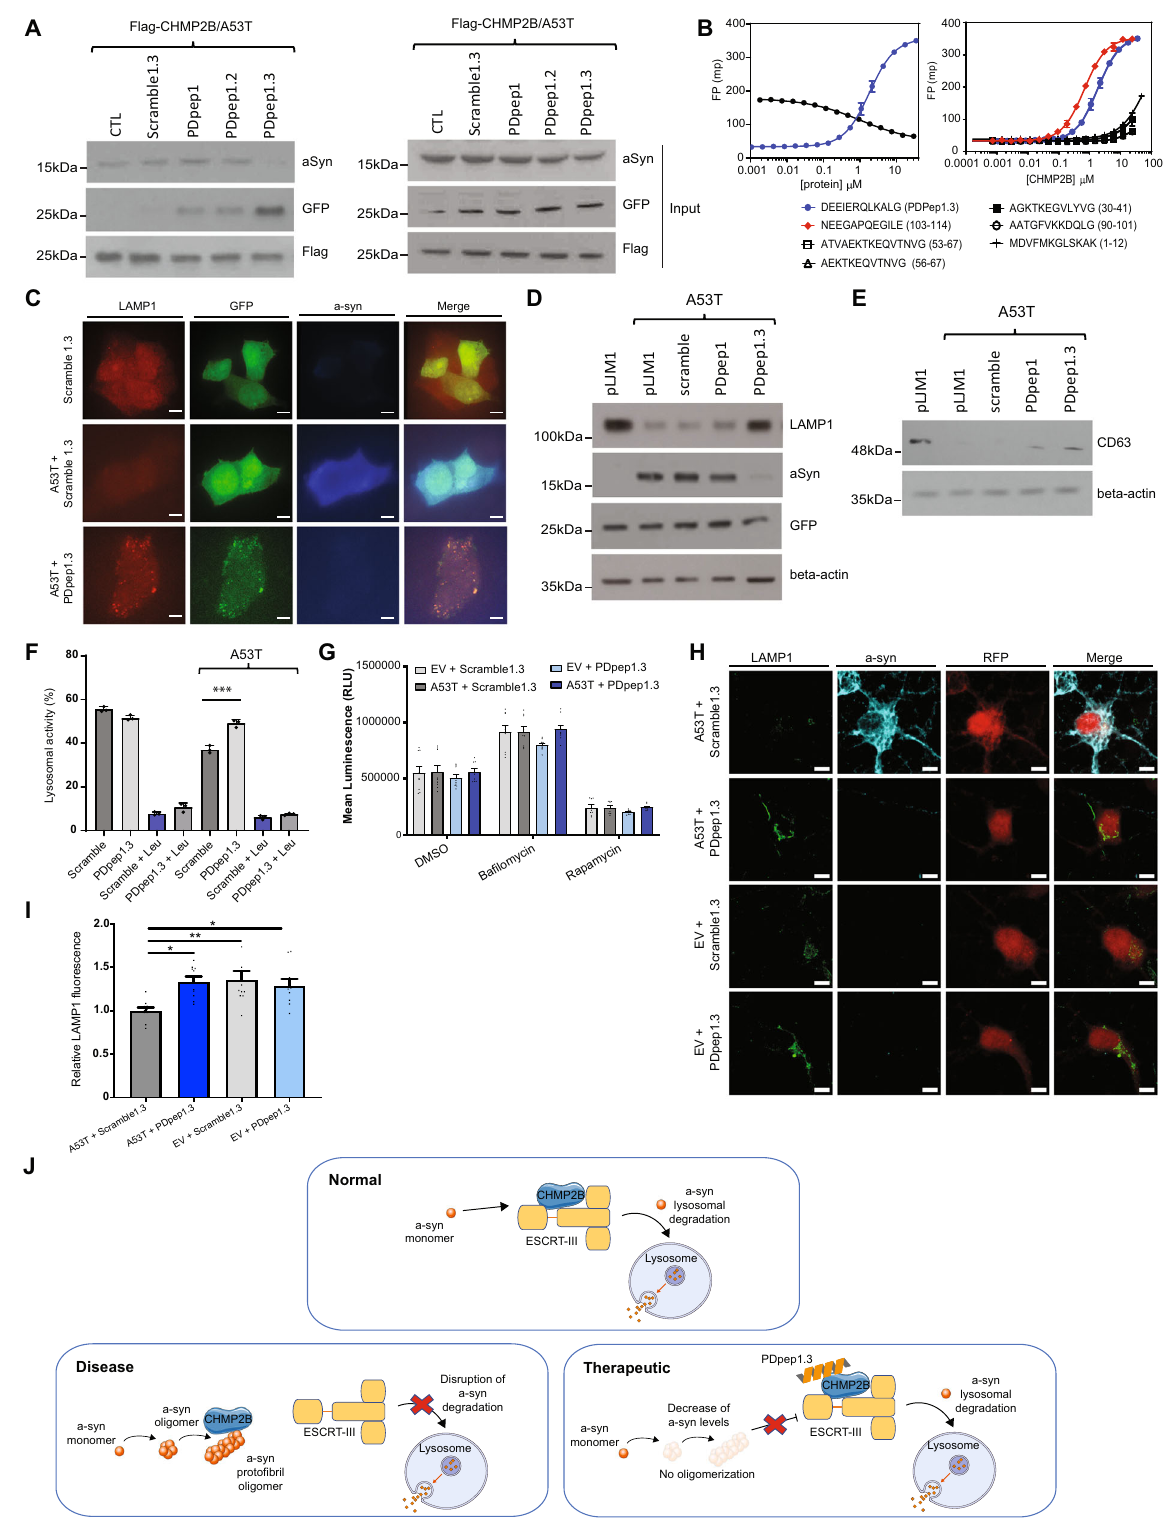
endolysosomal fl ux as measured using the assay described above (Fig. 6C). PDpep1.3 could not reduce a-syn levels in the presence of Ba fi lomycin A1, which inhibits the vacuolar-type proton pump responsible for acidi fi cation of lysosomes, suggesting that PDpep3.1 acts further upstream in the